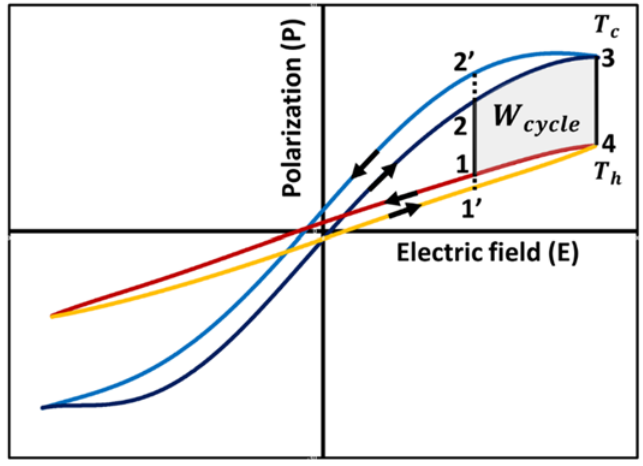
Figure 15. Modified Ericsson Cycle or Olsen cycle for pyroelectric generator. Table 2. Available work output, W cycle , based on Olsen cycle for different pyroelectric materials [103]. Data taken from references: [117,122–137].